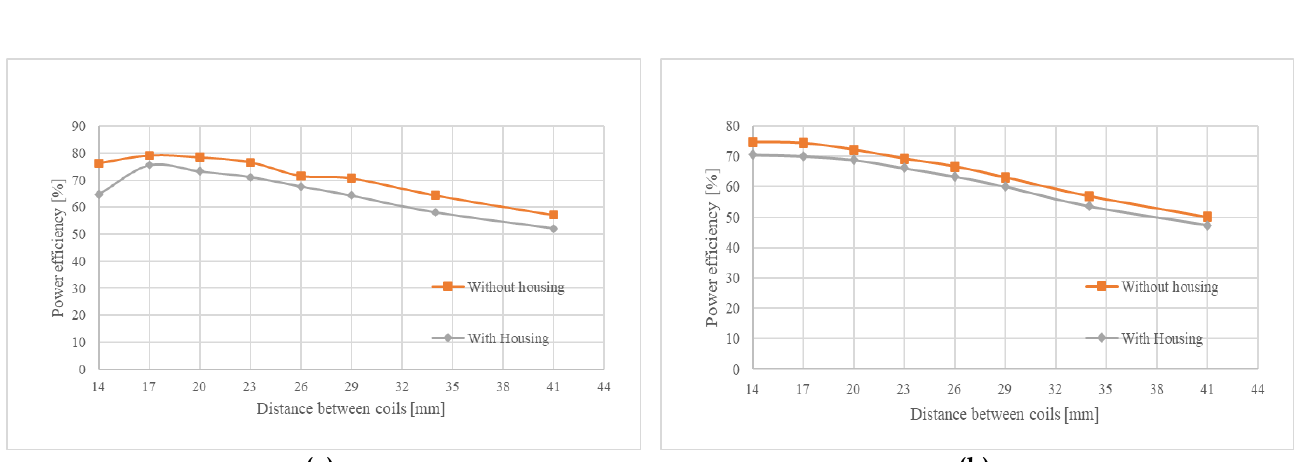
Figure 15. Power transmission efficiency over distance of the 24 V module ( a ) and the 48 V module